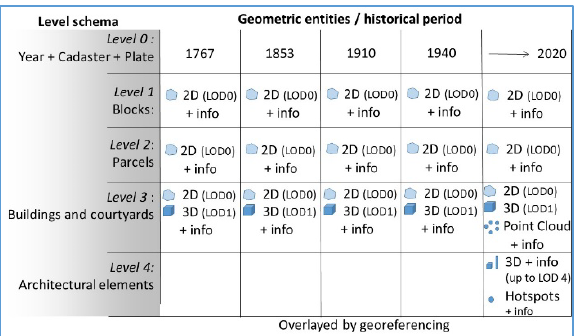
Figure 1. Summary of information per levels and per historic period. LOD are expressed according to CityGML